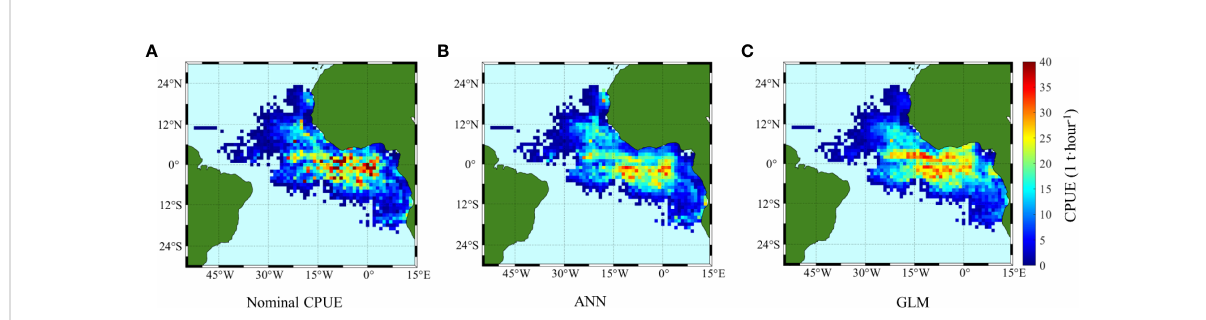
Figure 5A. In terms of environmental factors, CPUE increased as the Chl_a increased from 0.1 to 0.5 mg/m 3 (Figure 10E), and CPUE peaked when the Chl_a was 0.5 mg/m 3 and then decreased signi fi cantly with increasing Chl_a. When the SST (Figure 10F) was between 18 and 22°C, CPUE increased slowly with increasing SST. There was a large slope increase in CPUE from 23-28°C, while CPUE decreased brie fl y when SST was 25- 26°C; fi nally, CPUE peaked when SST was 28°C and then decreased